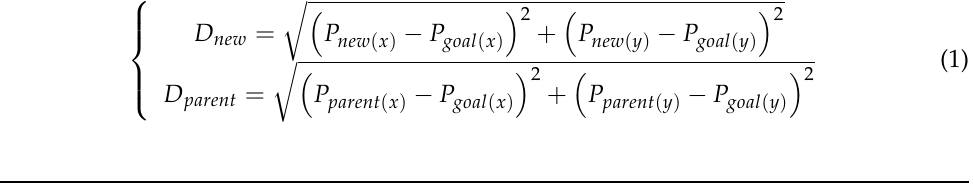
Algorithm 2. PPD-RRT algorithm.